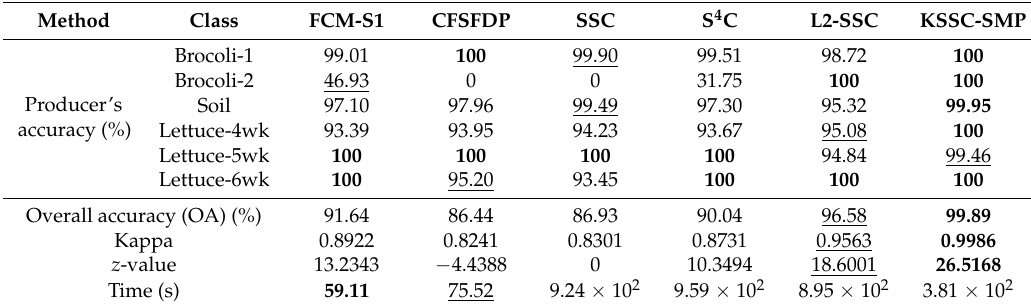
Figure 3. The cluster maps of the different methods for the Salinas image: ( a ) false-color image (R: 70, G: 27, B: 17); ( b ) ground truth; ( c ) FCM-S1; ( d ) CFSFDP; ( e ) SSC; ( f ) S 4 C; ( g ) L2-SSC; and ( h ) KSSC-SMP. Table 4. Quantitative evaluation of the different clustering algorithms for the Salinas image: the best result in each row is shown in bold, with the second-best result